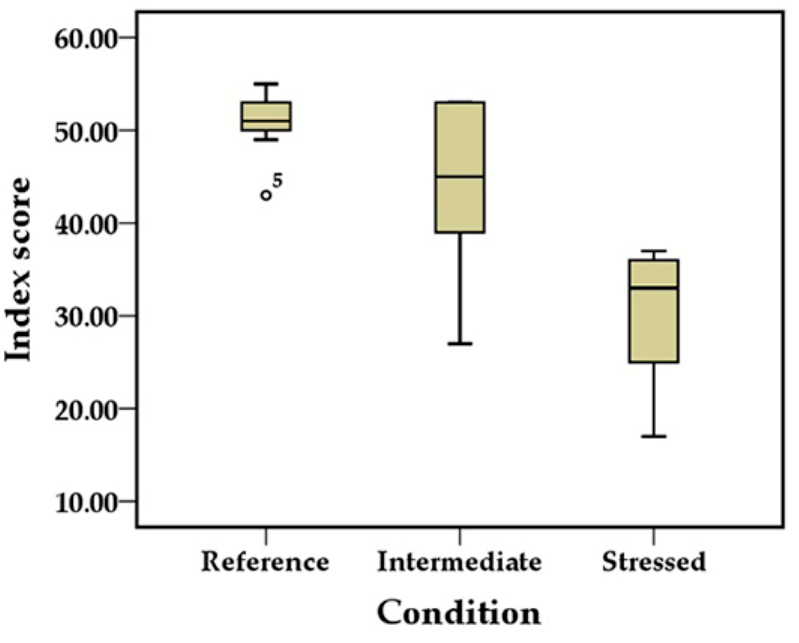
Figure 5. Box-and-whisker plot of the final index scores for Lao MMI used to discriminate between reference, intermediate, and stressed sites . Table 8. Water quality of 40 sampling sites (wadeable rivers and streams) in Lao PDR assessed by using surface water quality standards of Lao PDR (physicochemical method) and the developed Lao MMI.